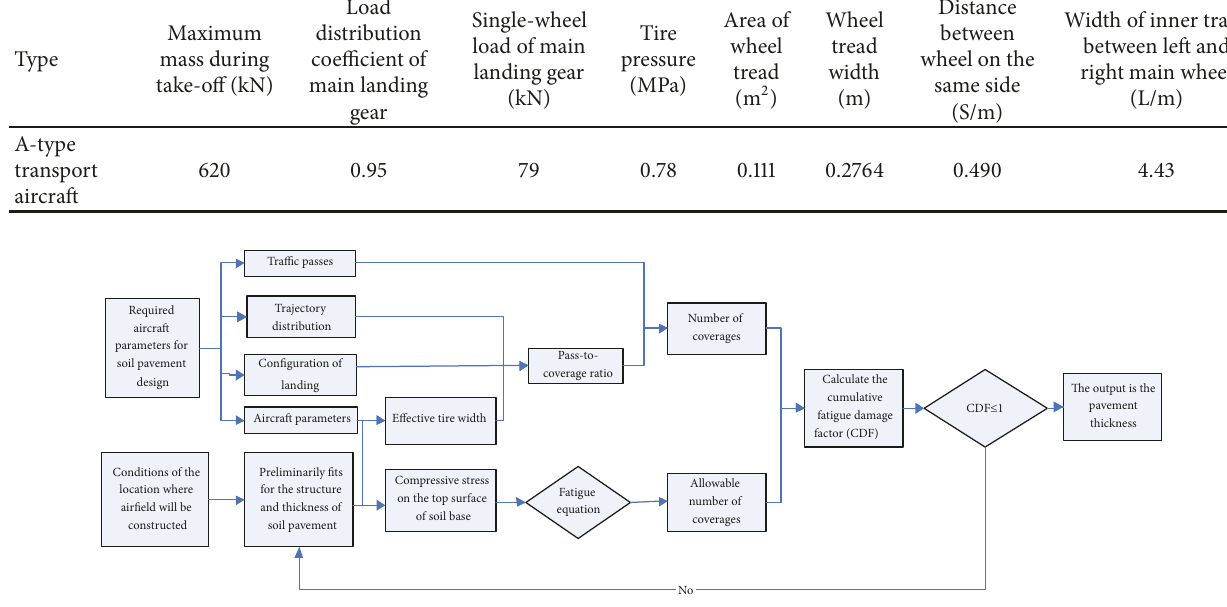
Figure 6: Flowchart of pavement design process.